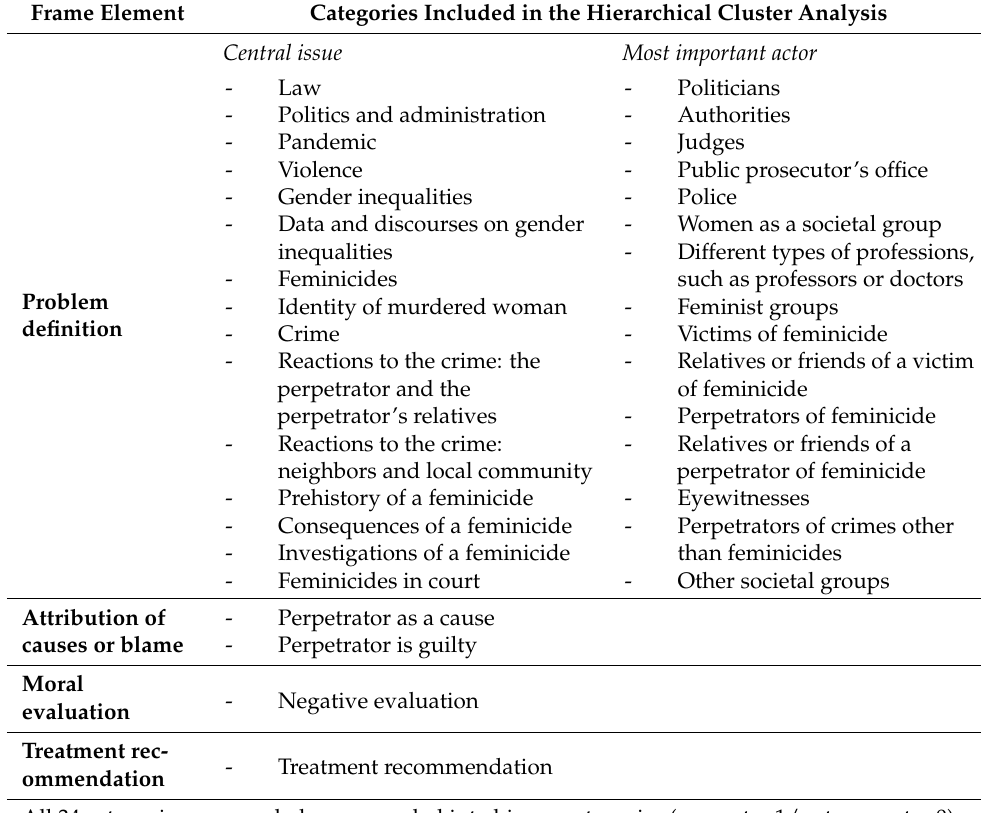
Table 1. Overview of categories included in the frame analysis. Frame